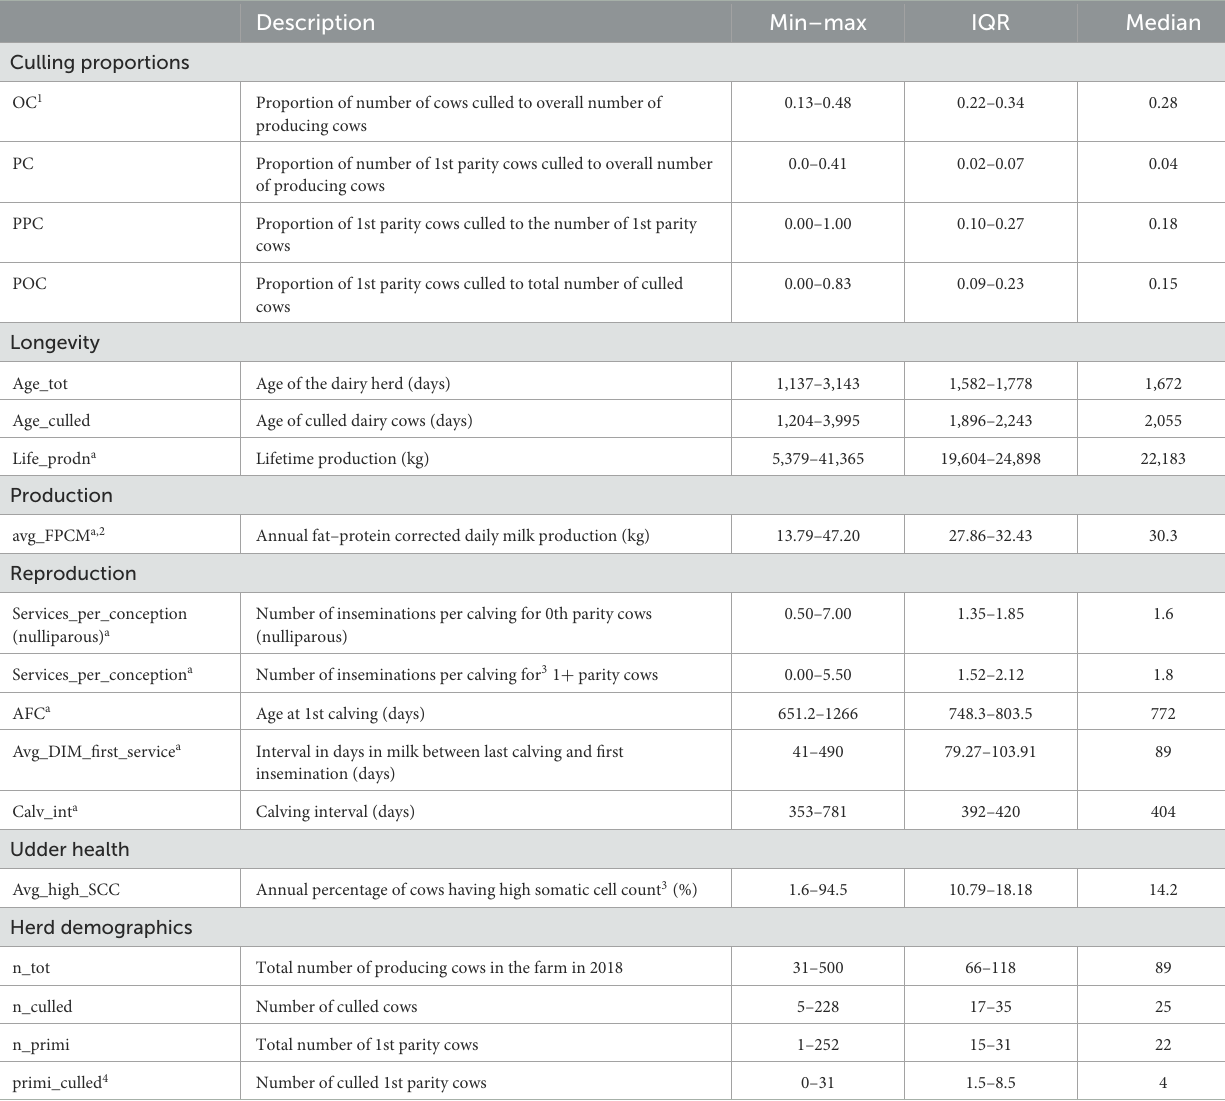
TABLE 1 Description and summary statistics of culling proportions and farm-level performance indicators grouped by performance area of the evaluated dairy farms ( n = 10,540).